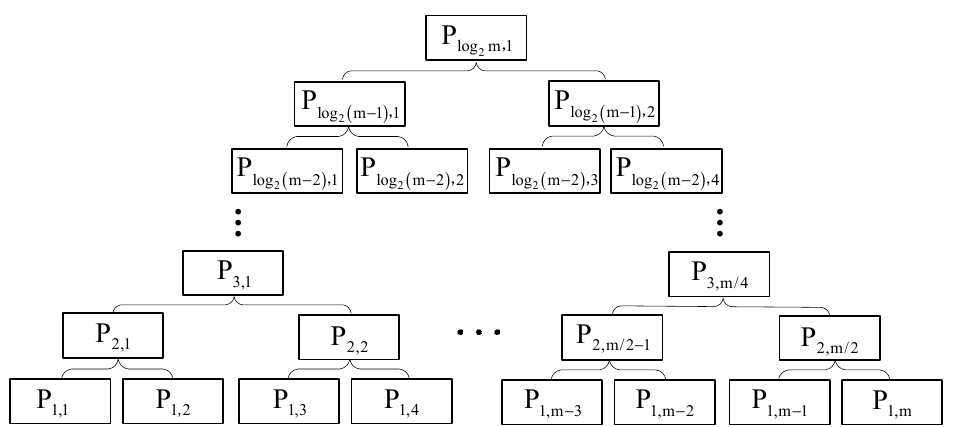
Figure 3. Hierarchical binary-tree-based